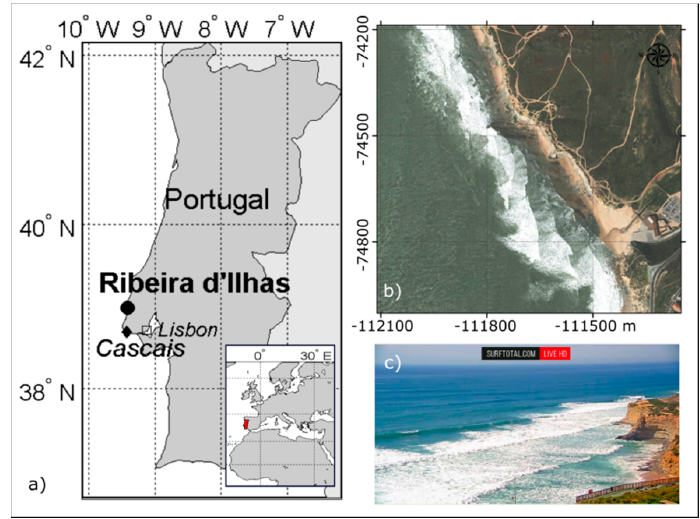
Figure 2. Study site map. ( a ) location of Ribeira d’Ilhas (circle) and Cascais tide gauge (diamond); ( b ) planar map; ( c ) surfcam image frame.